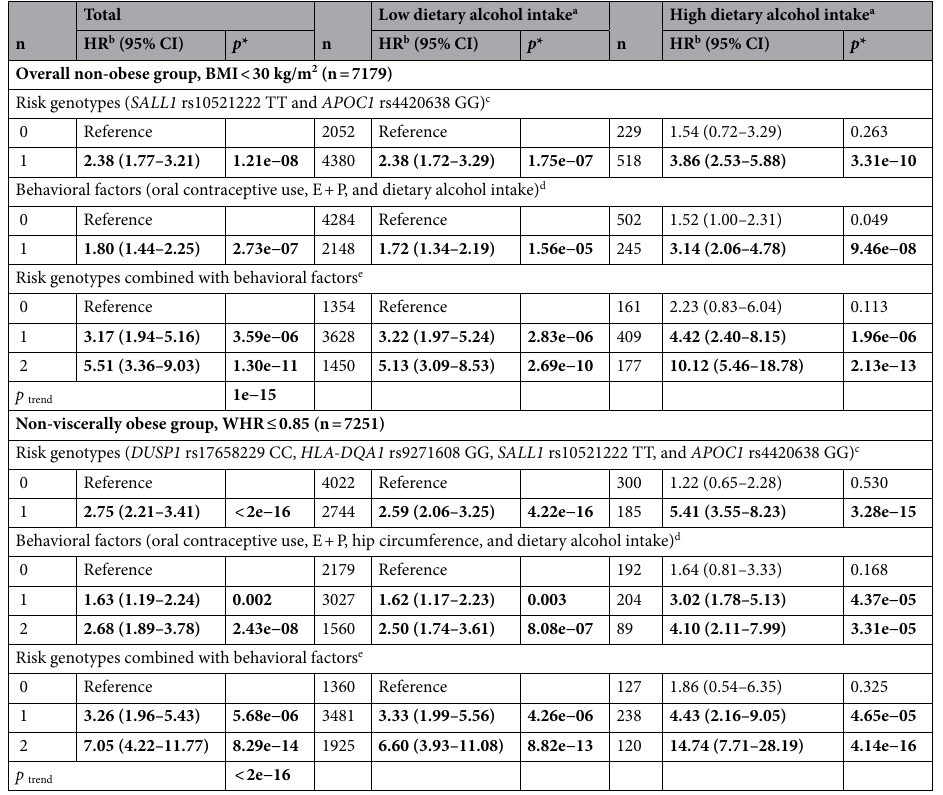
Table 4. Stratification analysis by BMI and WHR: joint effect of dietary alcohol intake with combined risk genotypes and behavioral factors on breast cancer risk. BMI, body mass index; CI, confidence interval; E + P, exogenous estrogen + progestin; HR, hazard ratio; WHR, waist-to-hip ratio. Numbers in bold face are statistically significant. * p values were adjusted to correct for multiple testing via the Benjamini–Hochberg approach. a In the overall non-obese subgroup, dietary alcohol was classified by a cutoff of 18 g/day (< 18 vs. ≥ 18); in the non-viscerally obese subgroup, dietary alcohol classified by a cutoff of 22 g/day (< 22 vs. ≥ 22); b Multivariate regression for risk genotype analysis was adjusted by family income, BMI, waist and hip circumferences, depressive symptom, number of cigarettes per day, age at menopause, duration of oral contraceptive use, E + P use, % calories from protein, and dietary alcohol (in total analysis); for behavioral factor analysis, variables tested for stratification and joint effect were not included as covariates in the multivariate regression. c The number of risk genotypes was defined as follows: [BMI < 30 subgroup] 0 (none or 1 risk allele) vs. 1 (2 risk alleles); [WHR ≤ 0.85 subgroup] 0 (none or 1/2/3 risk alleles) vs. 1 (4 risk alleles). d The number of behavioral factors was defined as follows: [BMI < 30] 0 (null risk behavior) vs. 1 (1 or more risk behaviors); [WHR ≤ 0.85] 0 (null risk behavior) vs. 1 (1 risk behavior) vs. 2 (2 or more risk behaviors). e The combined number of risk genotypes and behavioral factors was based on risk genotypes defined as 0 (low risk) and 1 (high risk) and based on behavioral factors defined as 0 (low risk) and 1 (high risk). The ultimate number of risk genotypes combined with behavioral factors was defined as 0 (low risk for genotypes and behaviors), 1 (high risk for either genotypes or behaviors), and 2 (high risk for both genotypes and